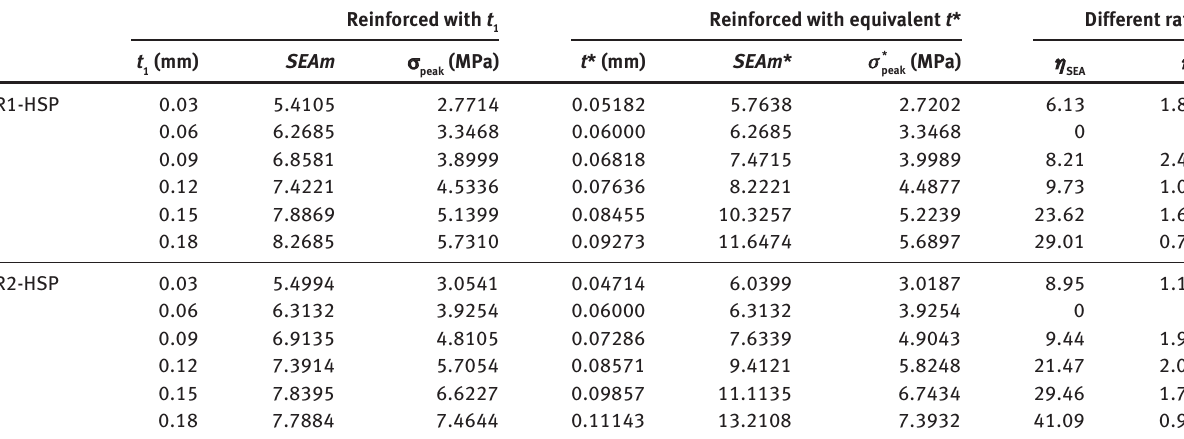
Table 5: Comparison on mechanical properties before and after equivalent